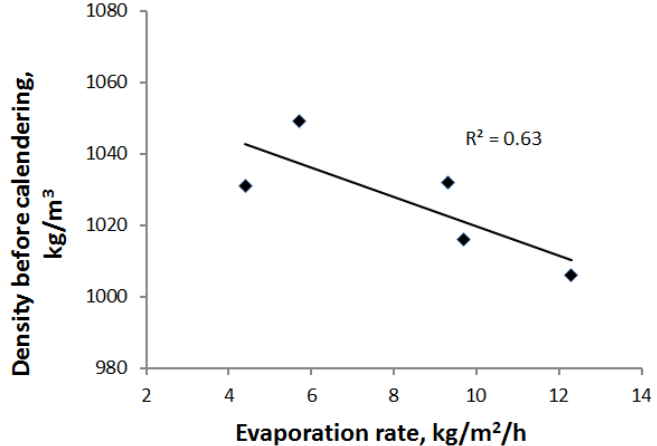
Figure 8. Sheet density before calendering is slightly affected by evaporation rate for contact and impingement drying.